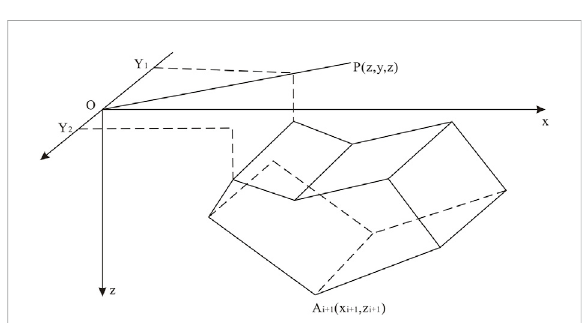
FIGURE 3 Schematic diagram of the two point fi ve dimension level prism, modi fi ed after Fan et al.,